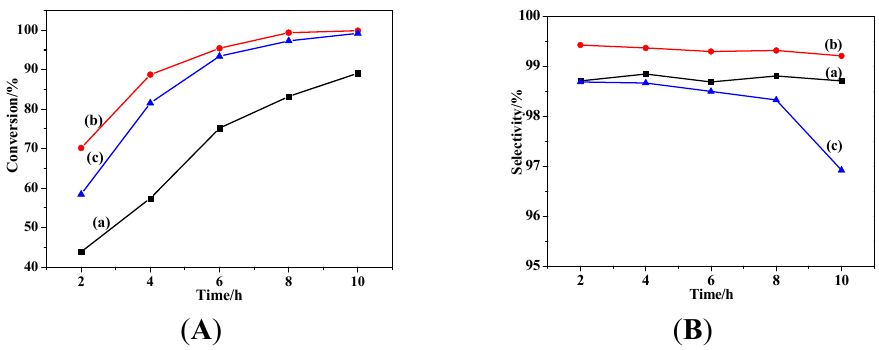
Figure 8. Effect of temperature and time on ( A ) conversion; and ( B ) selectivity. (a): 60 °C; (b): 70 °C; and (c): 80 °C.